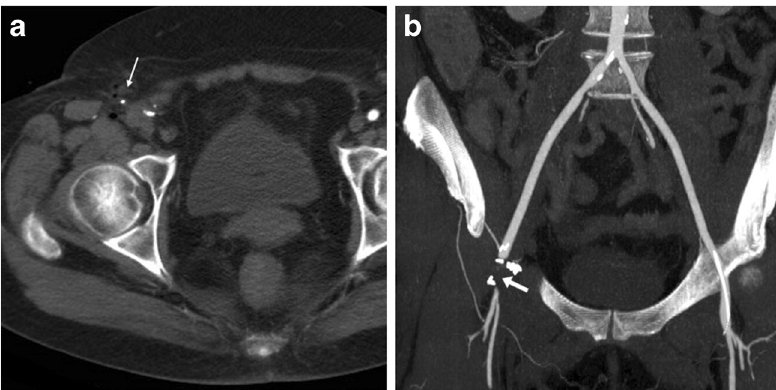
Fig.8 Segmentalocclusion ofthe punctured right CFA in a 65-year- old woman suffering from acute lower limb ischaemia following transarterial mitral valve replace- ment. Despite inconclusive find- ings on precontrast CT images (thin arrow in a, note similarity with Fig.1), CT angiography (B) showed non-opacification of a 2- cm segment of the CFA